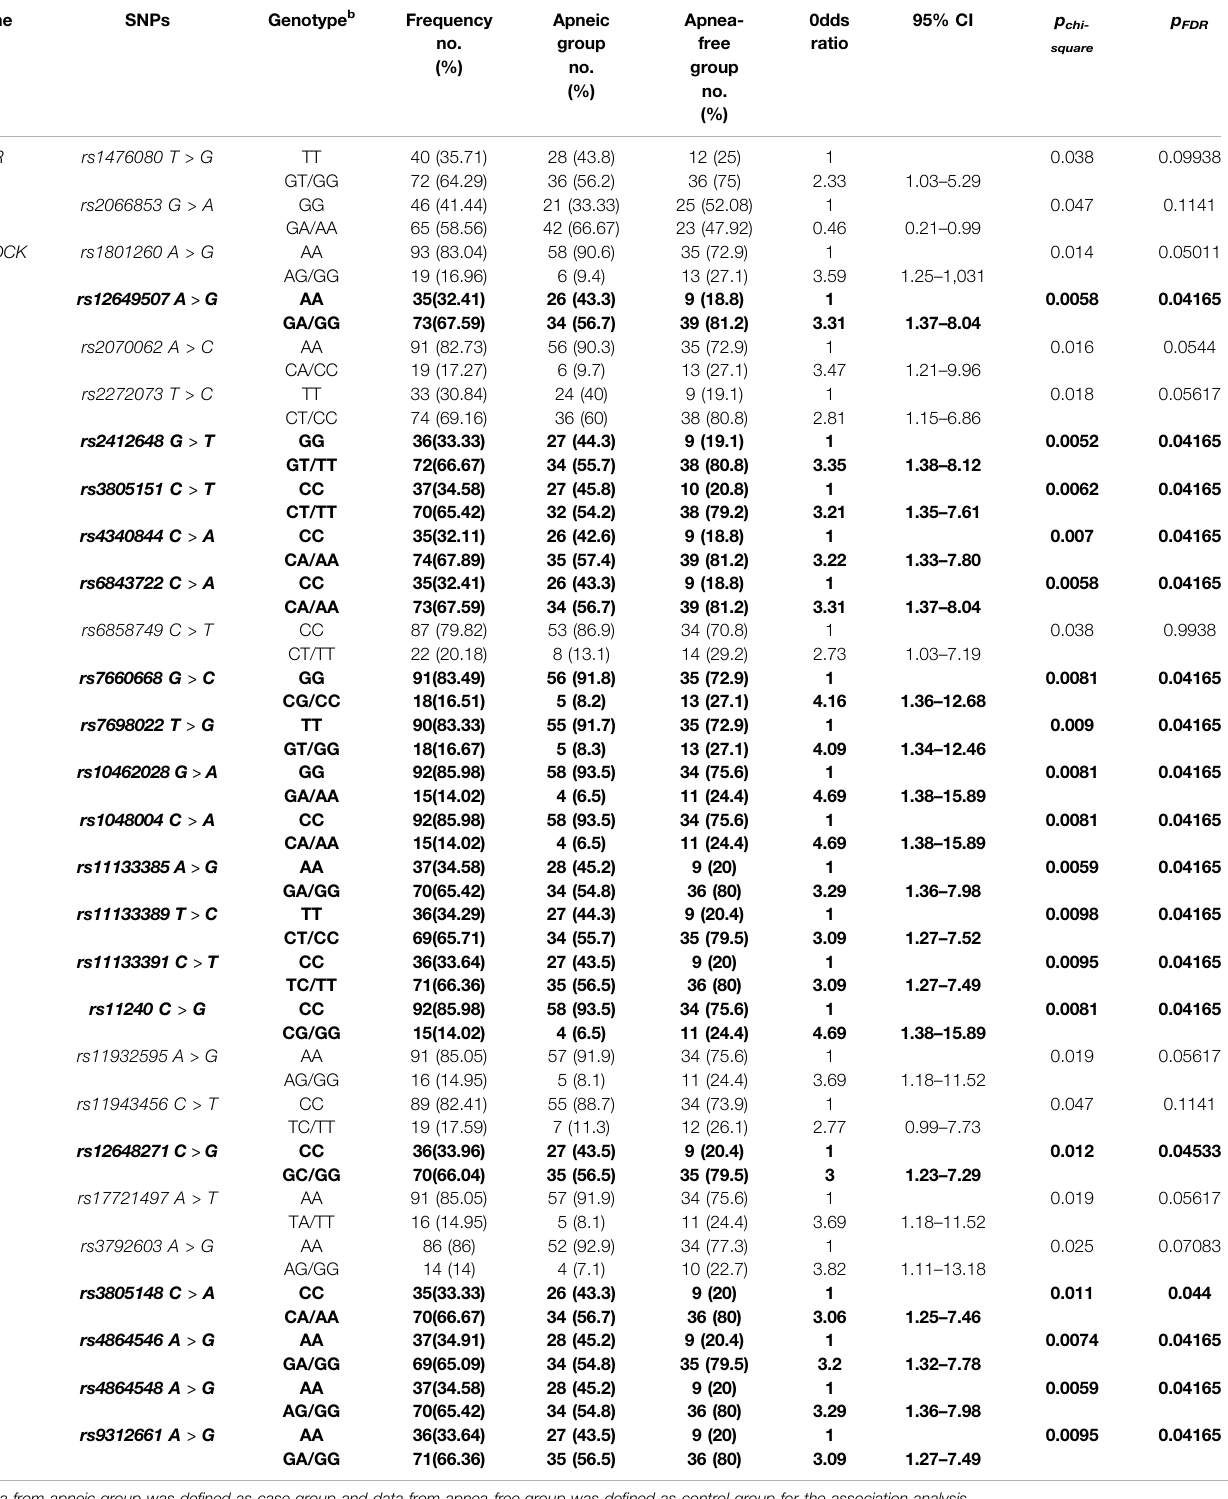
TABLE 2 | SNPs association with response to caffeine therapy among preterm infants in apneic and apnea-free groups a